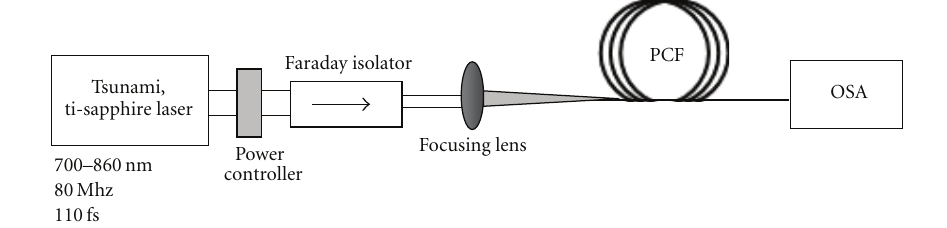
Figure 5: Experimental setup for supercontinuum generation.